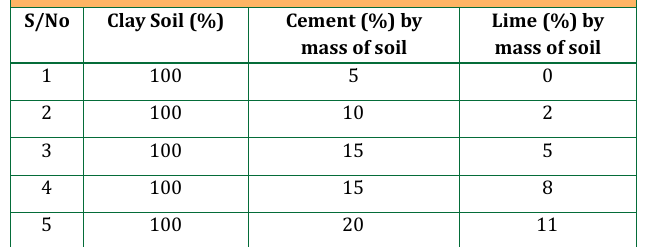
Table 1: Mix Proportion used for